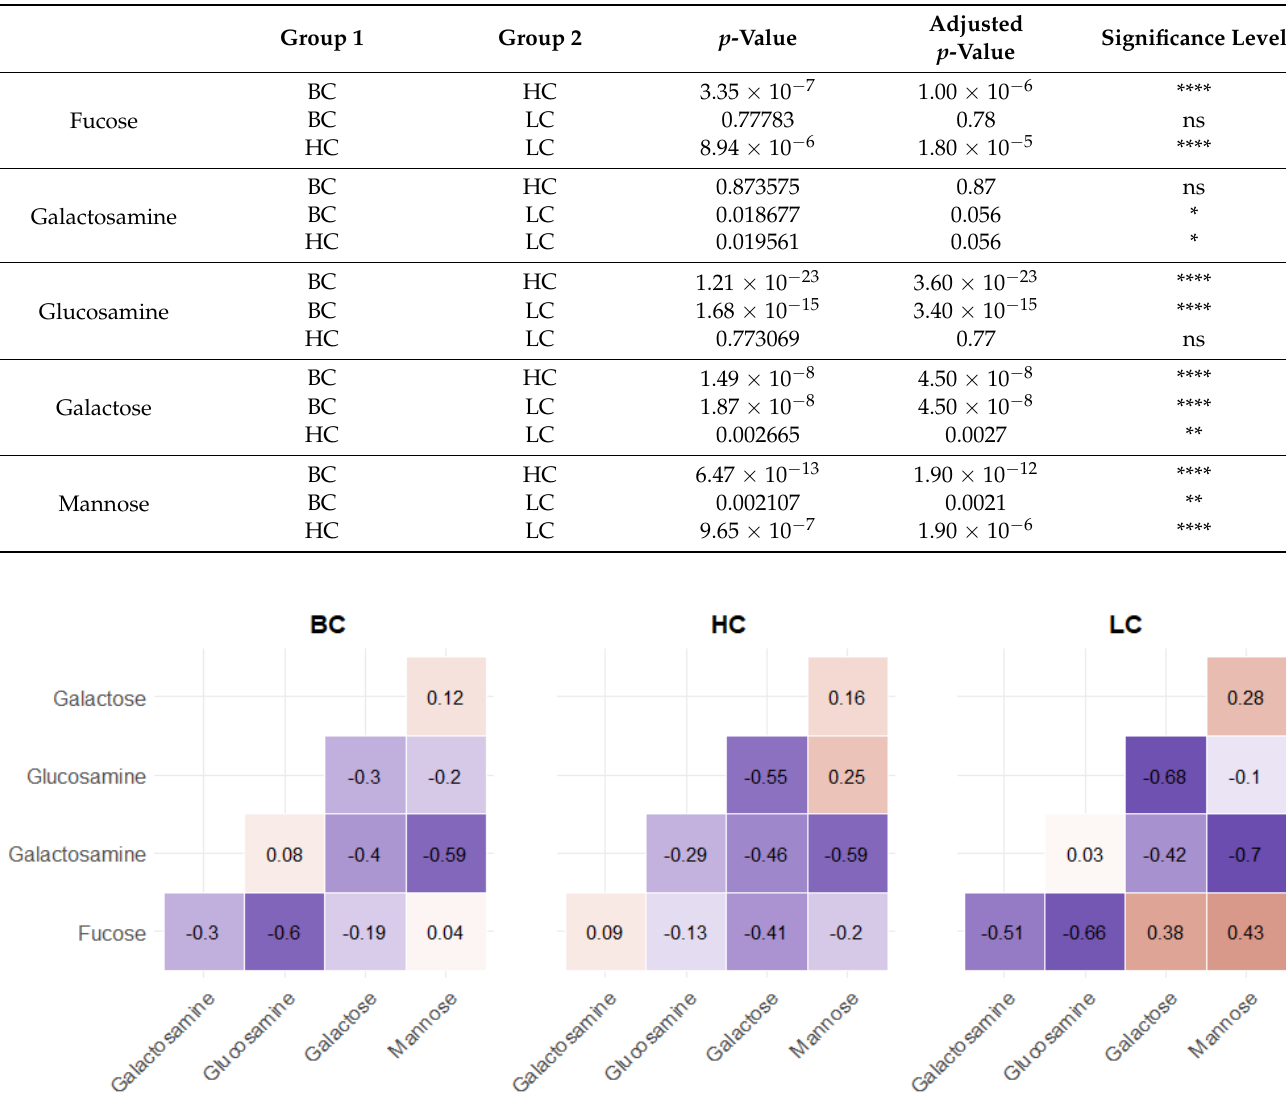
Table 4. Results of the t -test between pairs of groups performed on the hydrolyzed carbohydrates. * represents a p -value < 0.05, ** a p -value < 0.01, and **** a p -value < 0.001, ns = not significant.